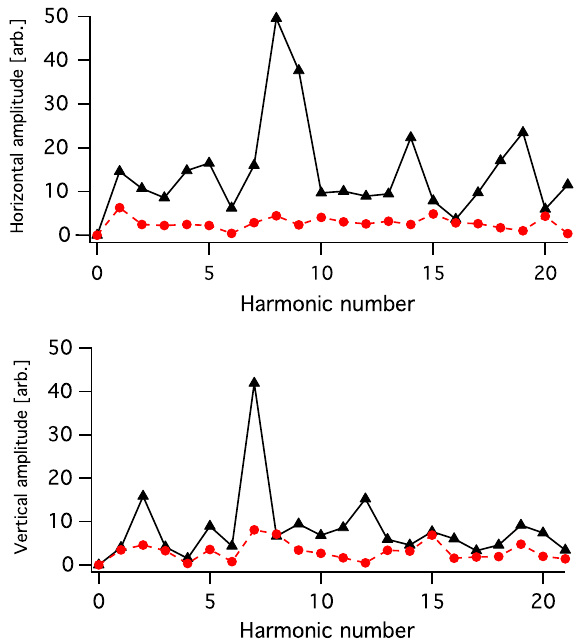
FIG. 10. Harmonics of the horizontal COD measured at 14 . 3 MeV =c before (black triangles) and after (red dots) correc- tion in both transverse